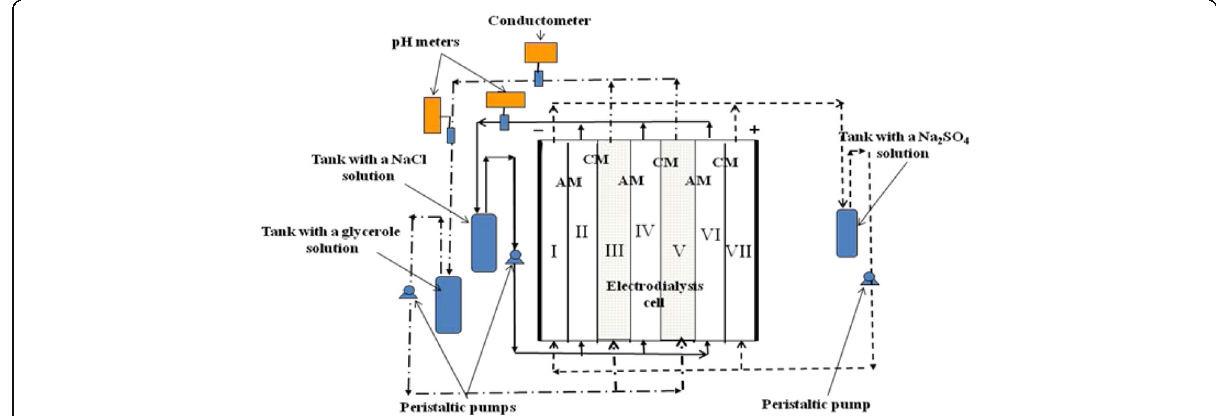
Fig. 1 Experimental setup for glycerol electrodialysis. Sections I and VII are the electrode compartments; II , IV , and VI are the concentration compartments; III and V are the desalination